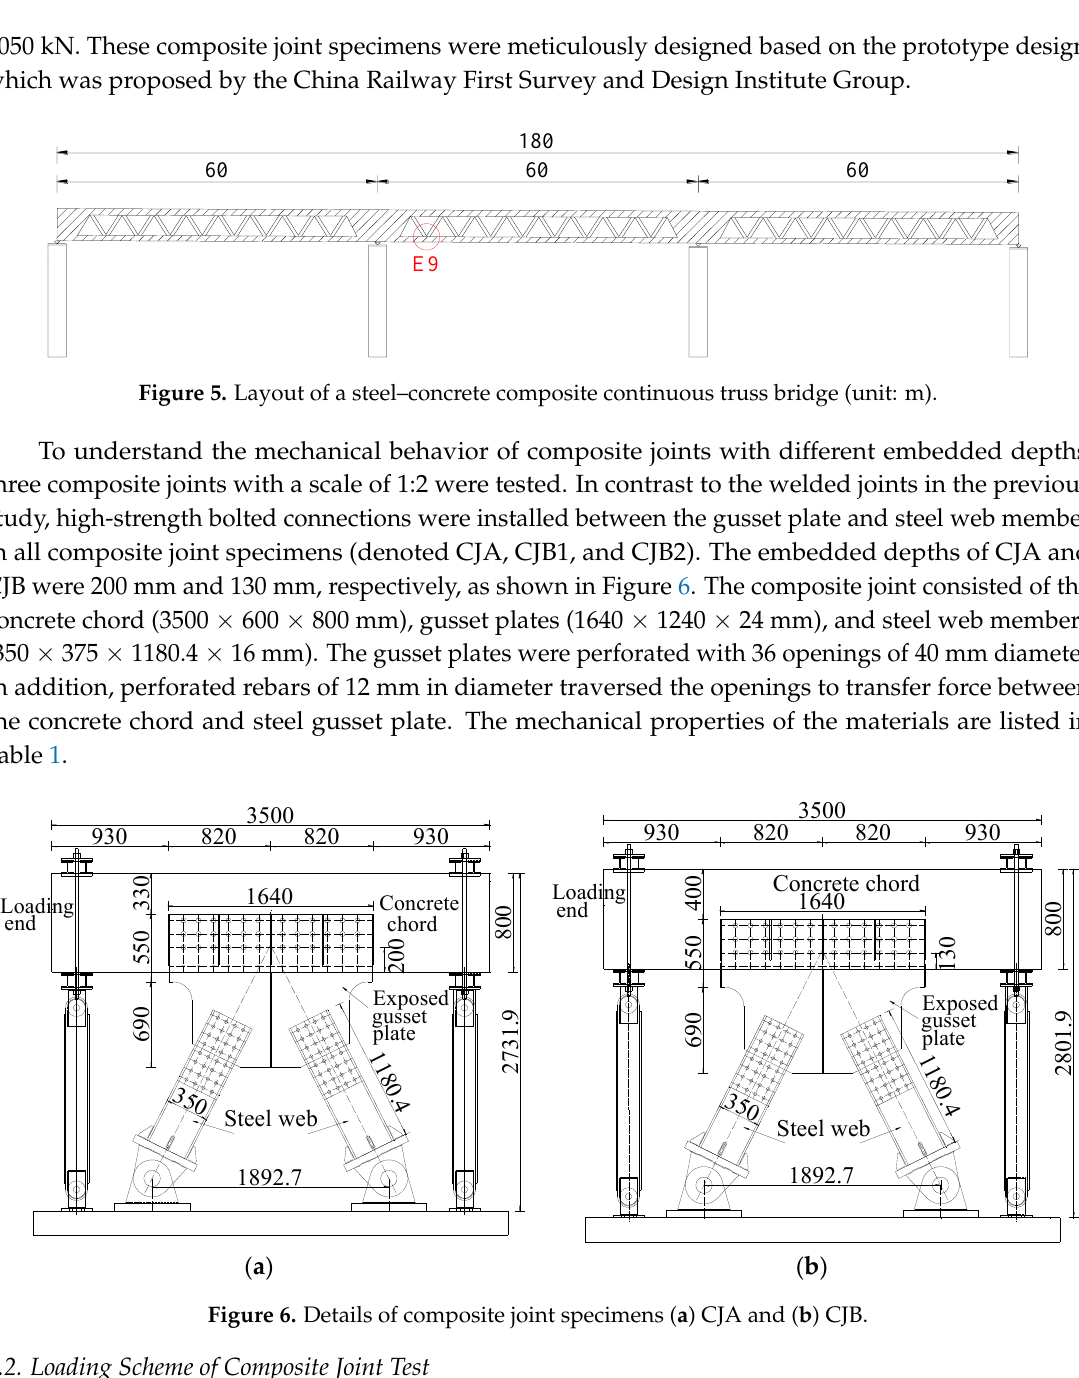
Figure 6. Details of composite joint specimens ( a ) CJA and ( b ) CJB.